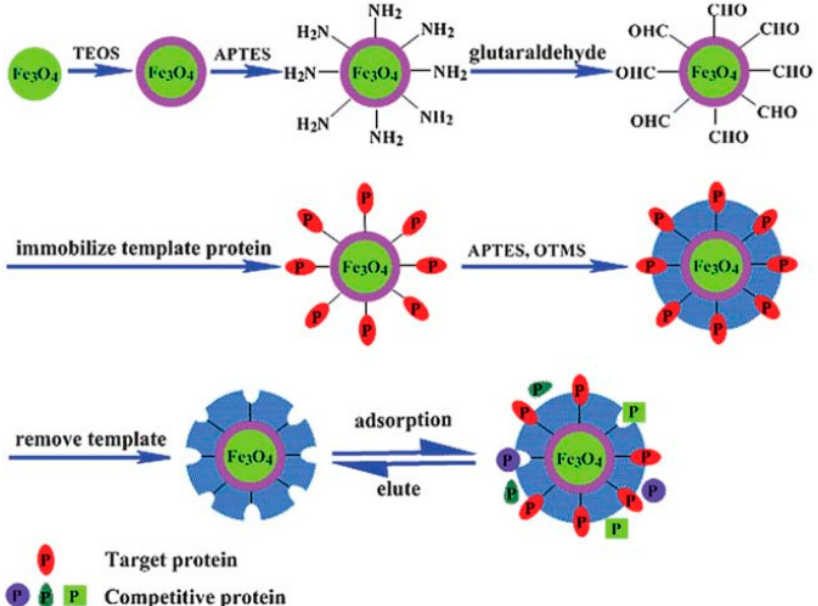
Figure 6. General method for synthesis of molecularly imprinted magnetic Fe 3 O 4 @MIP NPs using an immobilized template protein. In the protocol, the surface of Fe 3 O 4 NPs was transformed to a silica shell using tetraethoxysilane (TEOS) to form Fe 3 O 4 @SiO 2 . Then, the surface of Fe 3 O 4 @SiO 2 was reacted with 3-aminopropyltriethoxysilane (APTES) to introduce amino groups on the surface which were